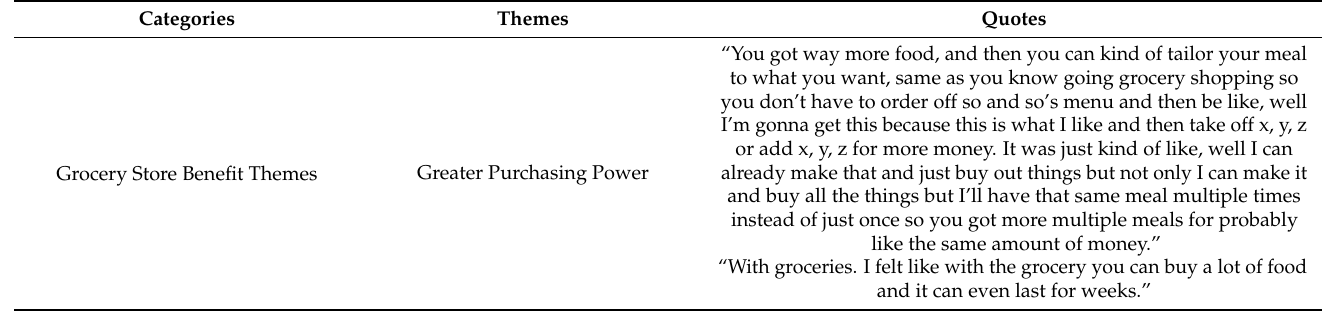
Table 3. Benefits and disadvantages of grocery store and restaurant delivery benefits, themes from participant